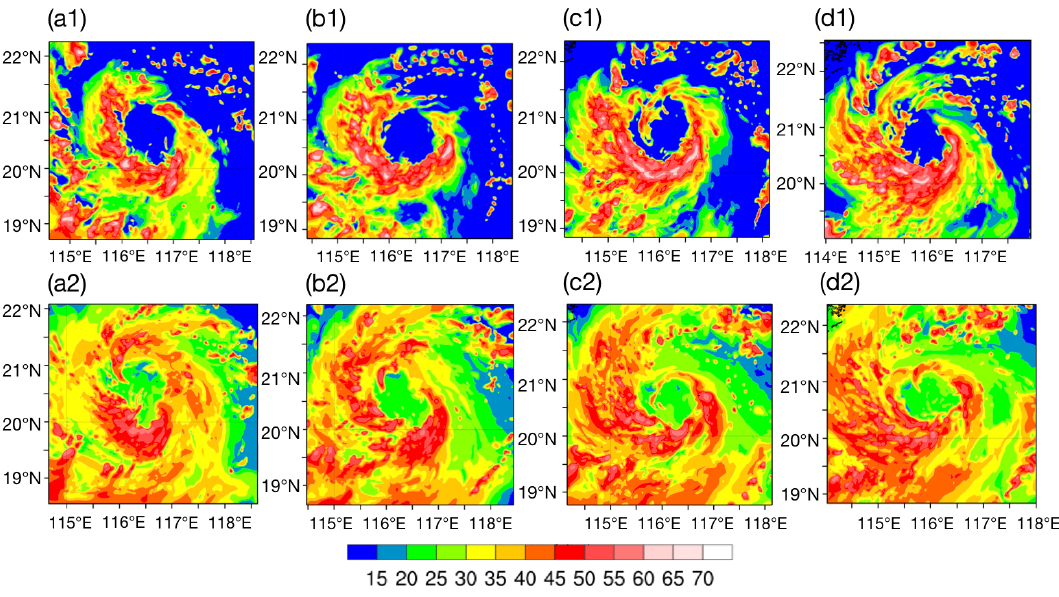
Figure 6. The hourly composite reflectivity (units: dBz) in CPL experiment ( a1 – d1 ) and FO experiment ( a2 – d2 ) from 1400 UTC to 1700 UTC 22